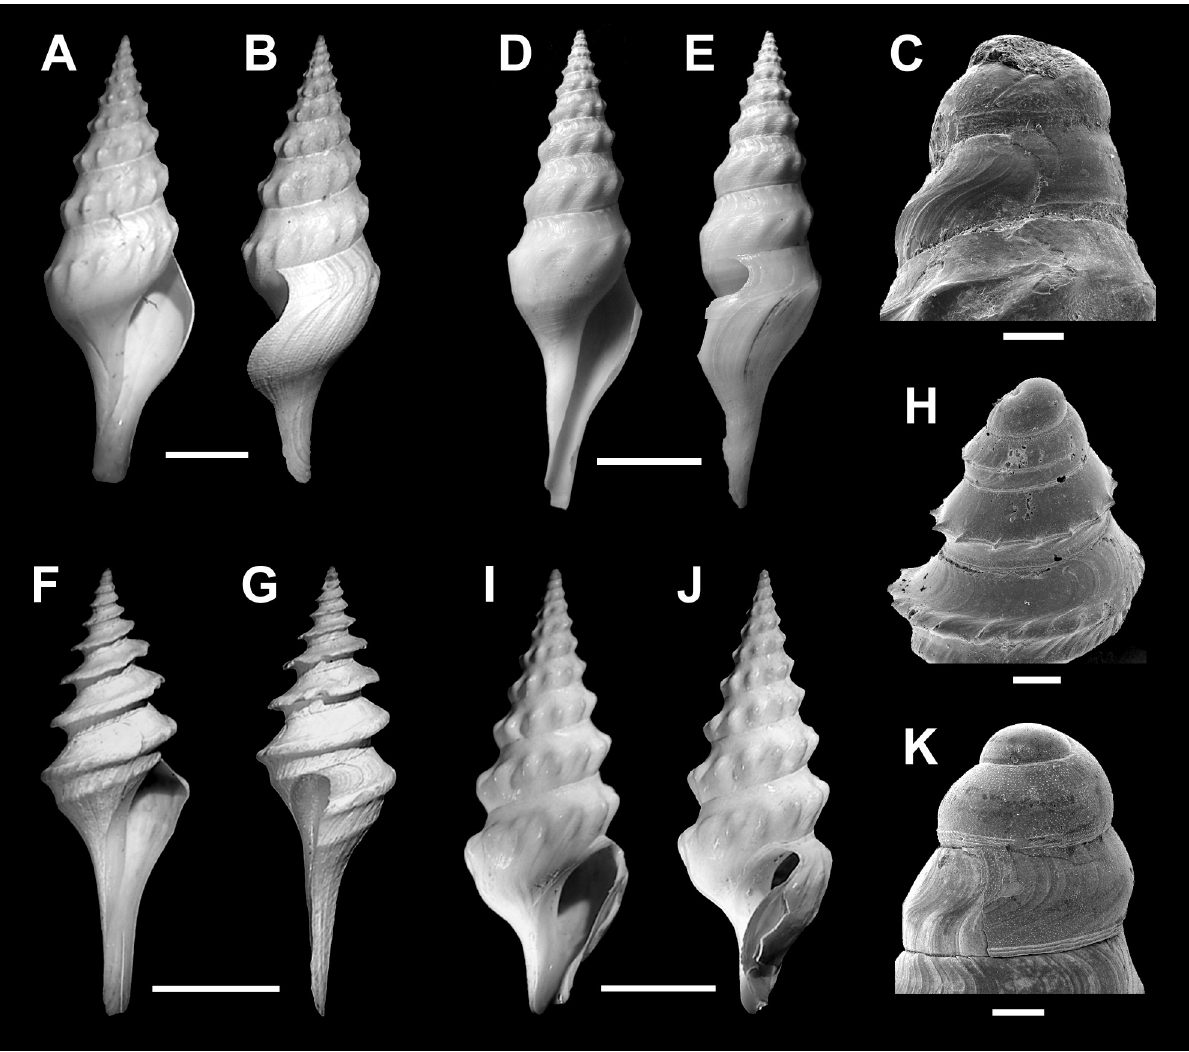
Fig . 2. – A, B, C, Leucosyrinx verrillii (Dall, 1881): A, B, IBUFRJ 16527, 30.16 mm, whole shell; C, IBUFRJ 16681, protoconch. D, E, L. tenoceras (Dall, 1889), IBUFRJ 16422, 52.01 mm, whole shell. F, G, H, L. ? subgrundifera (Dall, 1888): F, G, IBUFRJ 16705, 19.82 mm, whole shell; H, IBUFRJ 18267, protoconch. I, J, K, Splendrillia centimata (Dall, 1889): I, J, IBUFRJ 18263, 21.83 mm; K, IBUFRJ 18262, protoconch. Scale bars: A, B, F, G, I and J, 5 mm; D and E, 10 μm; C, H and K, 200 ral threads (Fig. 2C). Teleoconch whorls pagoda-like, showing a slightly concave region between the suture and the shoulder. Whorls sculptured with large, blunt, axially elongated nodules, beginning on their shoulder and continuing towards the inferior suture, about 14 on the 7 th whorl, and numerous fine spiral threads over the entire shell. Suture shallow. Base concave, with spiral threads on its upper half and smooth on its lower half. Labial sinus broad and moderately shallow. Inner lip reflected. Outer lip projecting forward. Siphonal canal long and wide. Aperture elliptical.